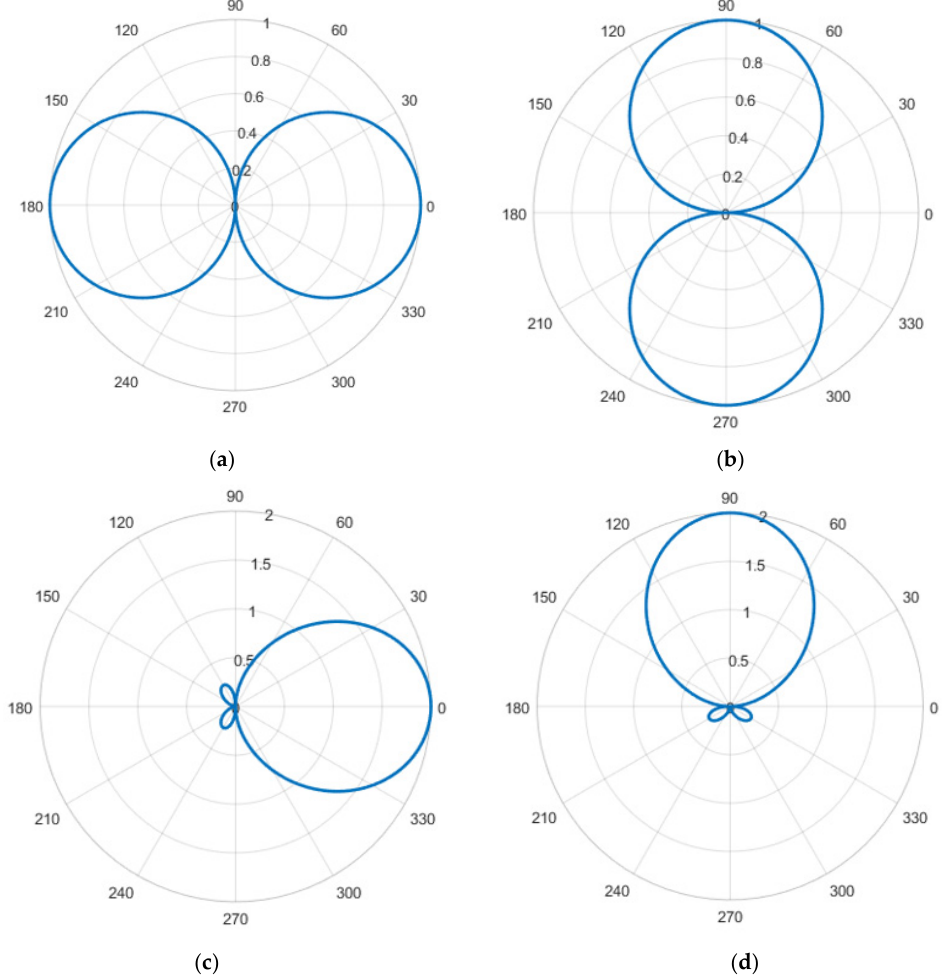
Figure 8. Directivity map. ( a , b ) v c ( t ) ; ( c , d ) [ p ( t ) + v c ( t )] v c ( t ) In order to achieve unambiguous orientation to the target, a new weighted combina- tion of acoustic pressure and vibration velocity is used to form a new combination of vi- bration velocity with a single directivity, as shown in Equation (12).